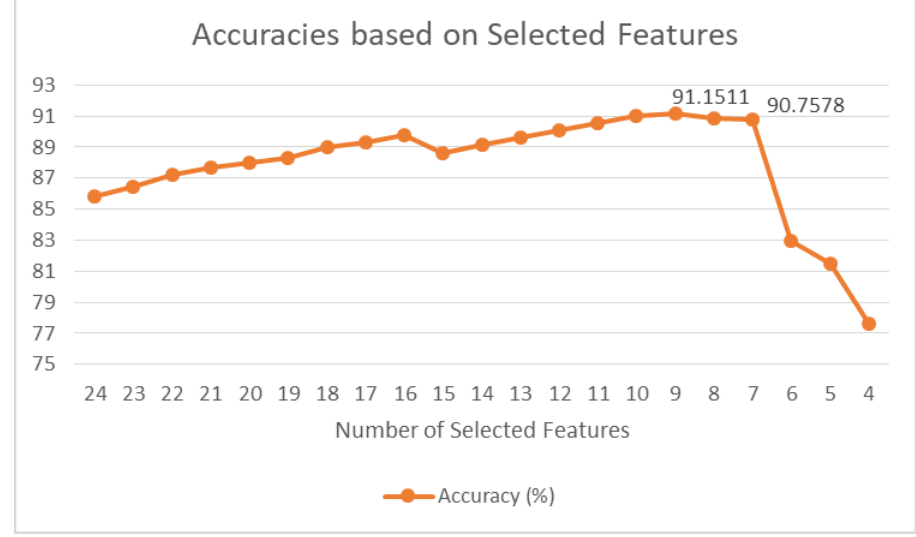
Figure 5. Accuracies of prediction models with respect to stepwise feature selection.